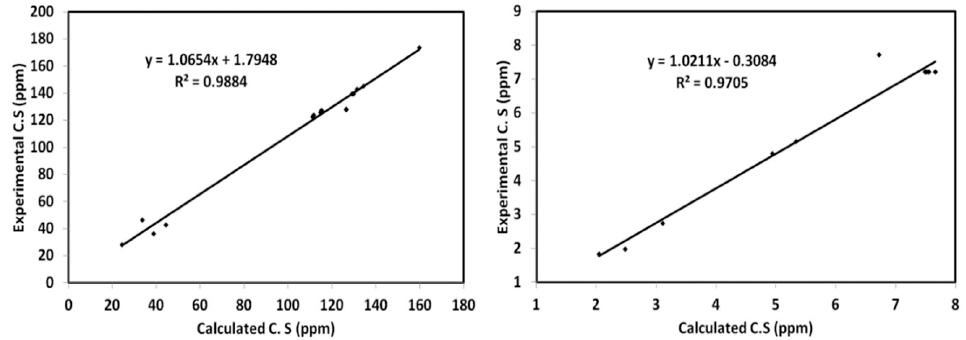
Figure 10. 1 H- and 13 C-NMR diagrams, indicating harmony between the computed and experimental results.